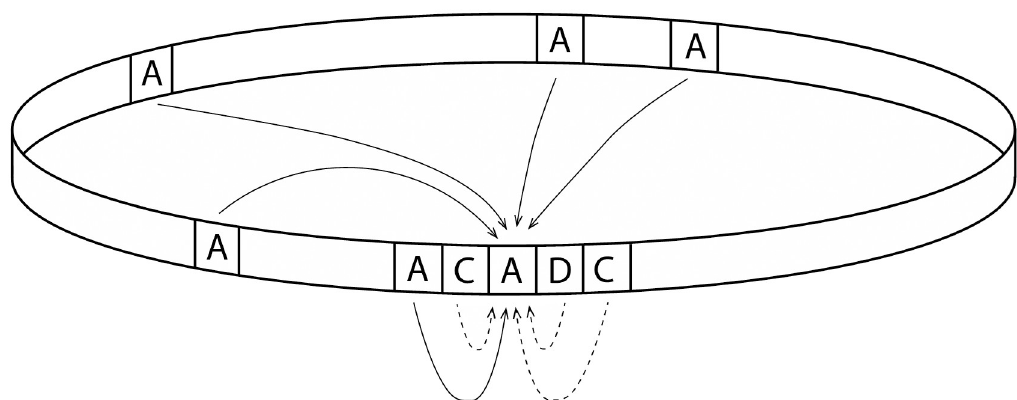
Fig 1. Model illustration. An illustration of the model, showing four local and four global connections of an individual with identity A. Positive feedback is received from connections to individuals with the same identity (solid) and negative feedback from those to dissimilar identities (dashed). Local connections represent externally constrained interactions (geography, workplace, etc.) and may be heterogeneously positive and negative. Global connections represent interactions afforded by technology. These are selected to be positive and are thereby homogenously positive. The magnitude of the feedback is the product of the strength of the identity of both individuals.